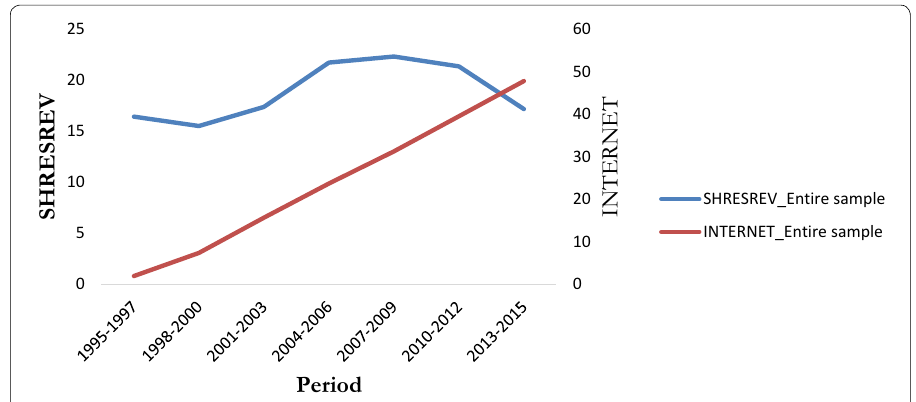
Fig. 1 Comparative evolution of “SHRESREV” and “INTERNET” over the full sample. Note : Non‑overlapping 3‑year average periods data have been used here. Source :